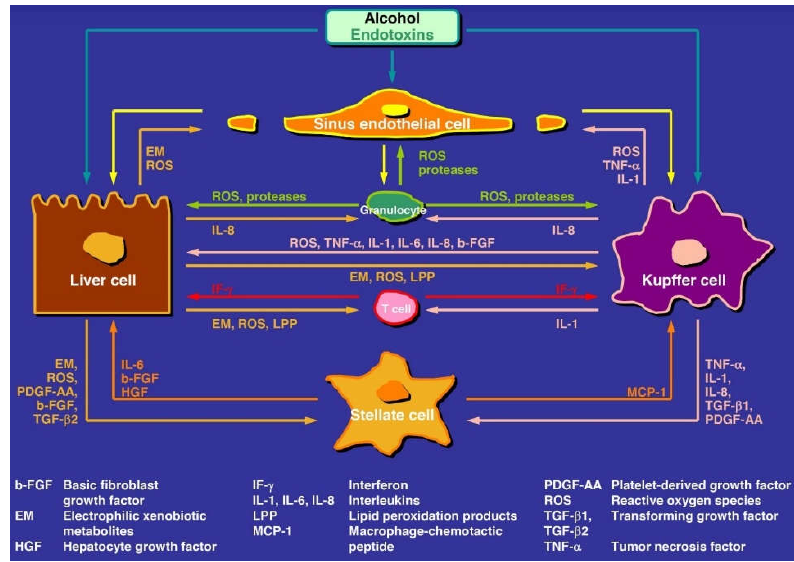
Figure 9. Hypothetical steps leading to alcoholic hepatitis. The pathogenesis of alcoholic hepatitis involves various mediators and cell types of the liver, some of the steps need confirmation and are therefore hypothetical. The original figure was published in a recent report [25] and is reproduced with permission of the Publisher Taylor & Francis (Didcot, UK).